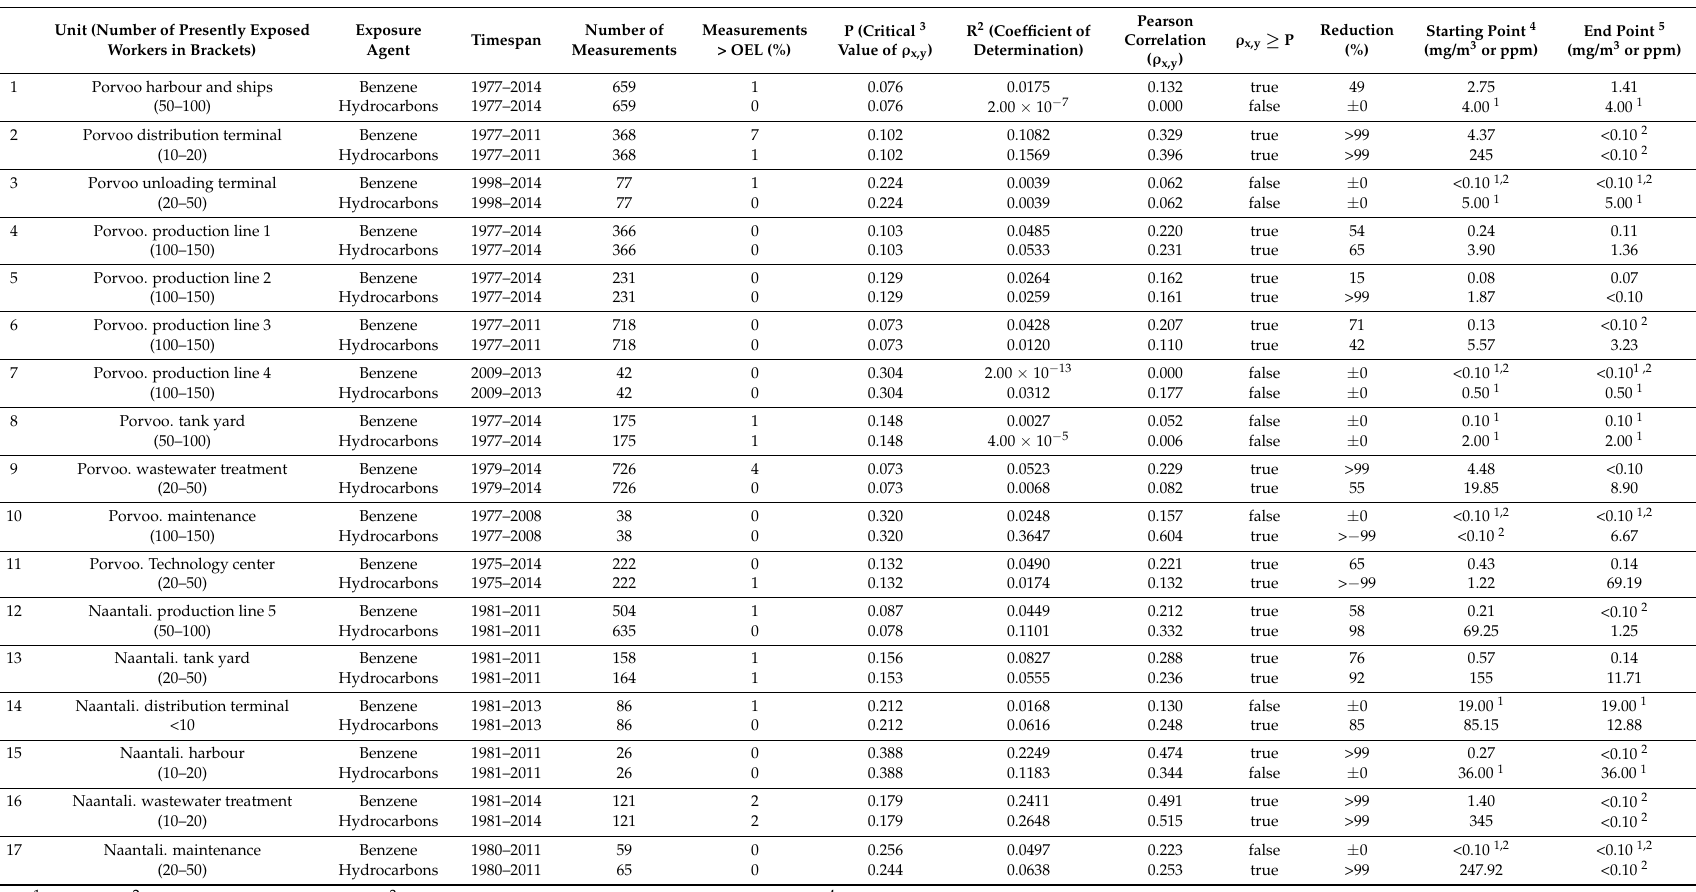
Table 2. Air concentrations, measurements and